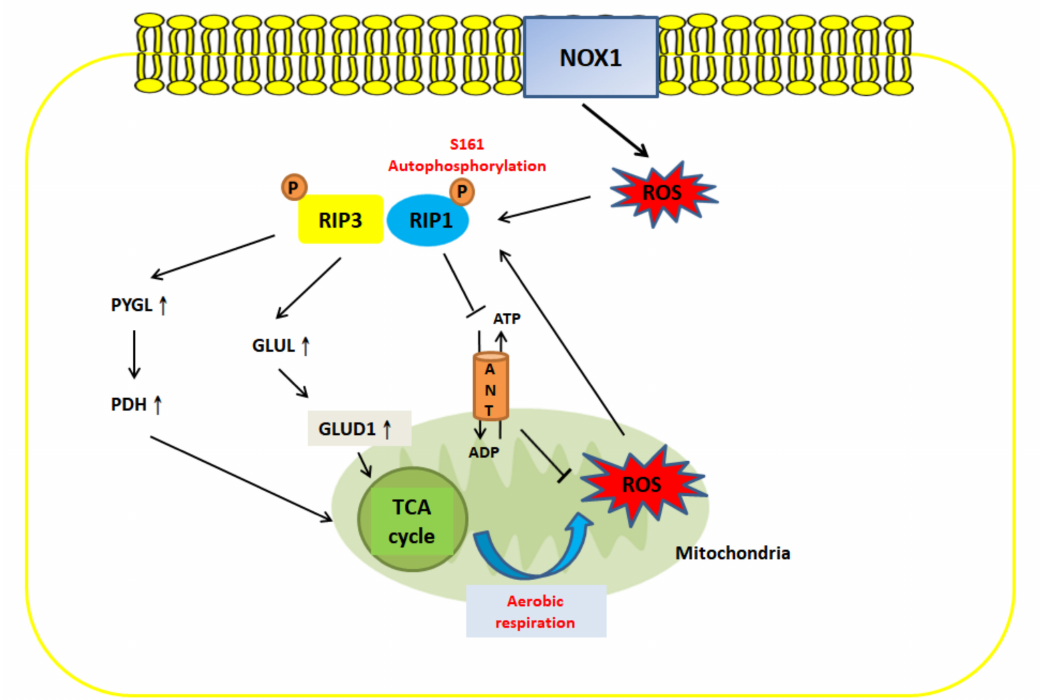
Figure 3. The crosstalk between ROS and necroptosis. ROS and necroptosis can form a positive feedback loop. Extramitochondrial ROS production by NOX1 or mitochondrial ROS generation through oxidative phosphorylation modifies the C257, C268 and C586 residues of RIP1 and